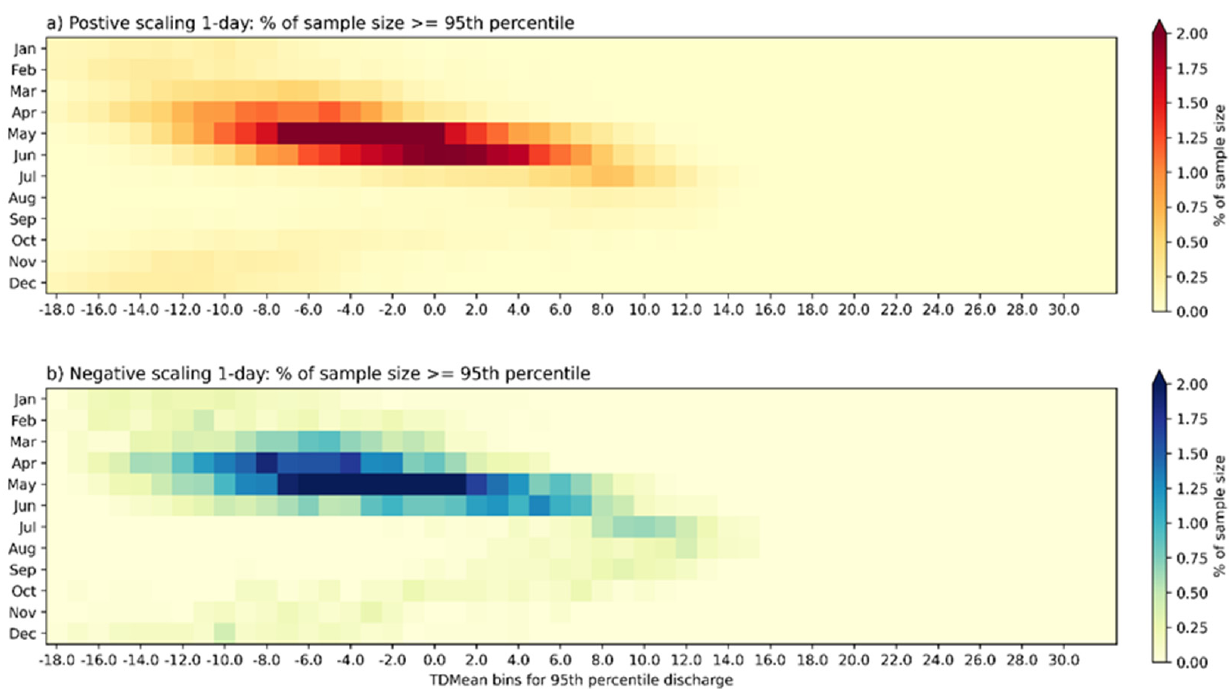
Figure 5. Monthly distribution of sample size of scaling by PRISM daily mean dew point temperature with at least 95th percentile of discharge ( a ) for positive scaling with discharge and ( b ) negative scaling with dis-charge.